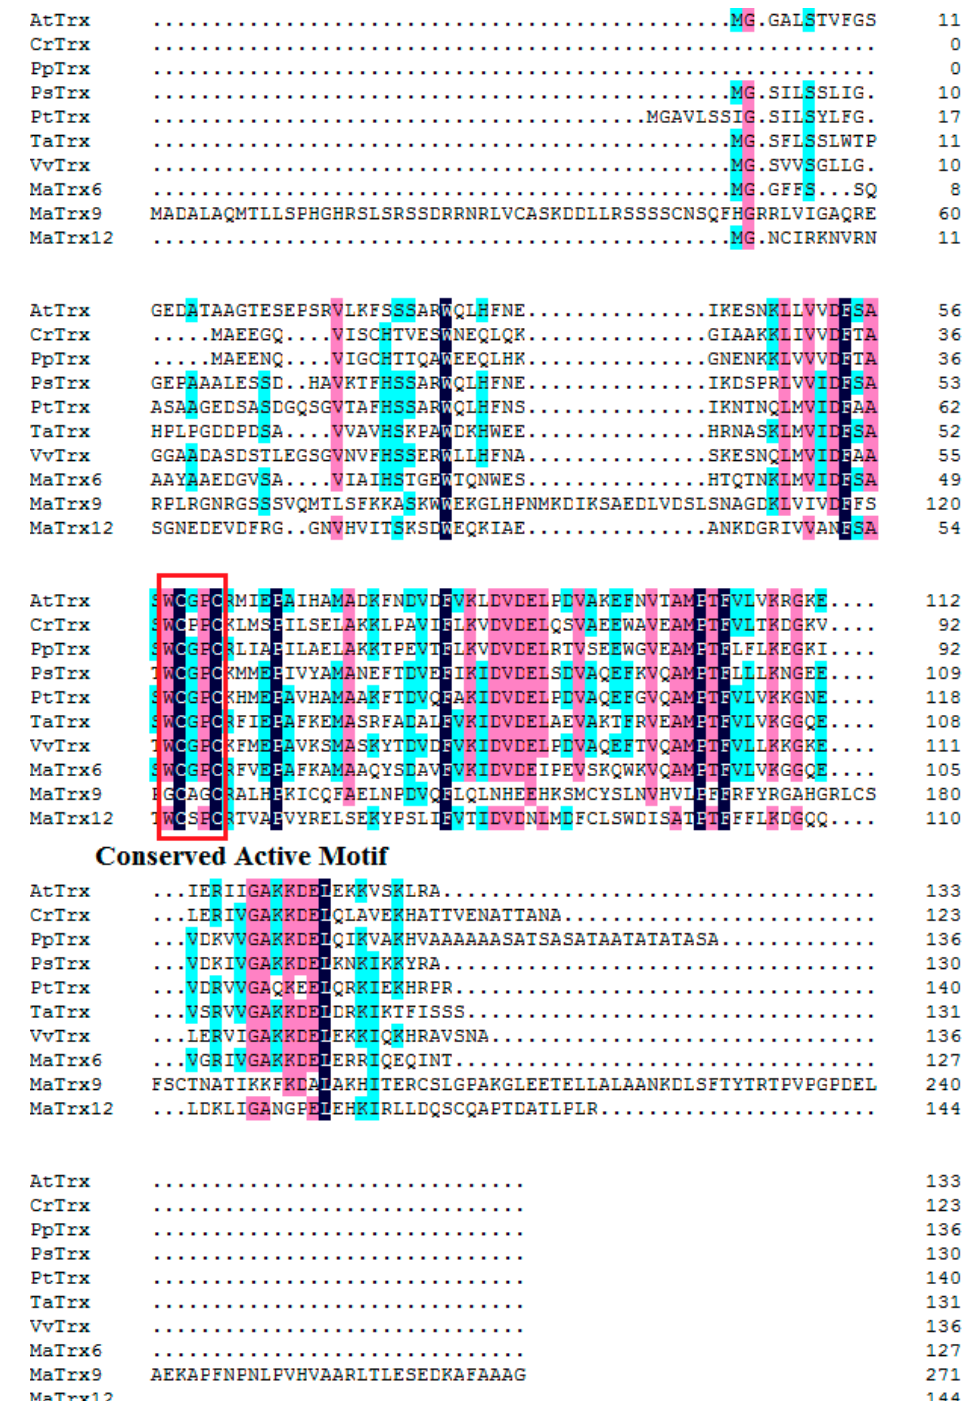
Figure 1. Homology comparison of amino acid sequence alignment of banana ( Musa acuminata ) Trxs with other plants. The selected sequences were Trx from Citrus reticulata (AAP33009.1), Prunus persica (AAL26915.1), Pisum sativum (AAO12855.1), Populus tomentosa (XP_002324032.2), Arabidopsis thaliana (AAC49353.1), Triticum aestivum (ACH61777.1) and Vitis vinifera (XP002282318.1) by DNAMAN V8. The conserved active motif was boxed.